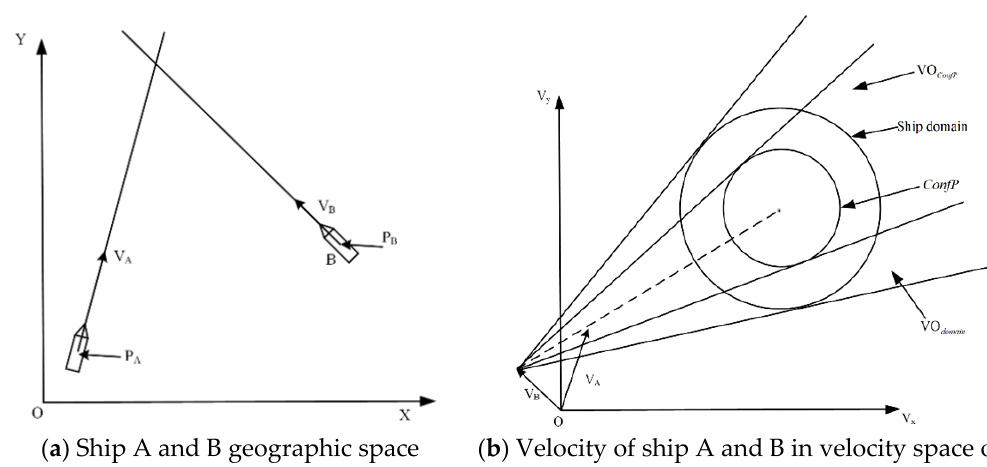
Figure 2. Illustration of TCR.